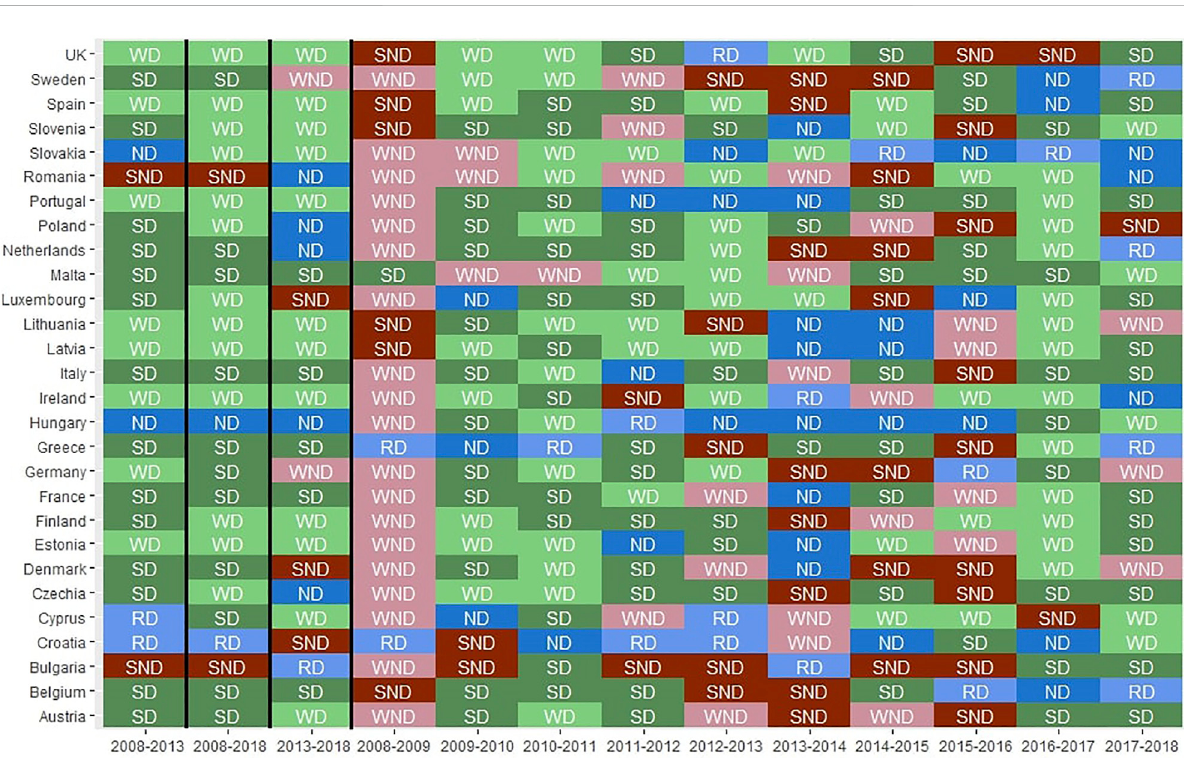
FIGURE 6 N 2 O emissions decoupling. Source: authors ’ calculation based on EEA,